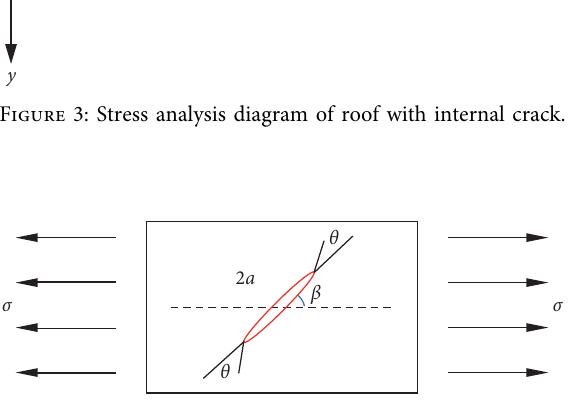
Figure 2: Stress analysis diagram of crack-free roof.